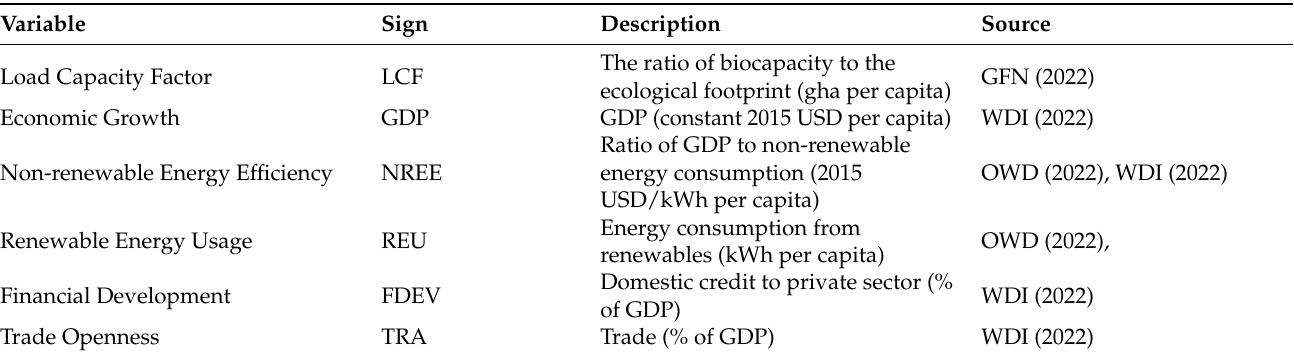
Table 1. Description of Data for the study.